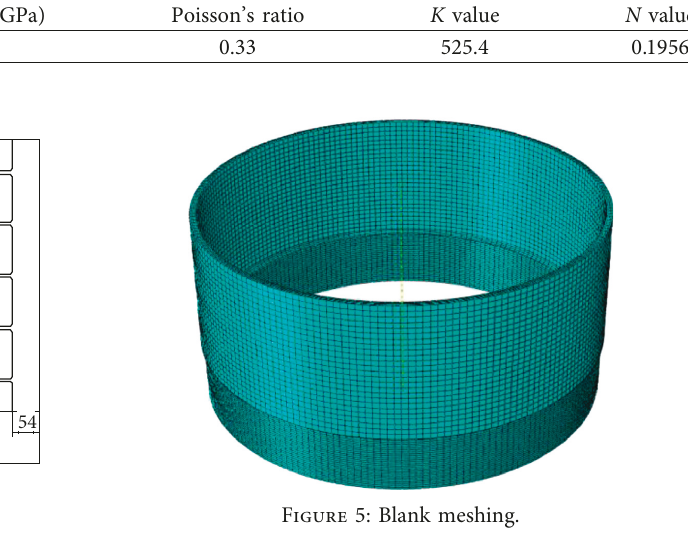
Table 2: Material performance parameters.